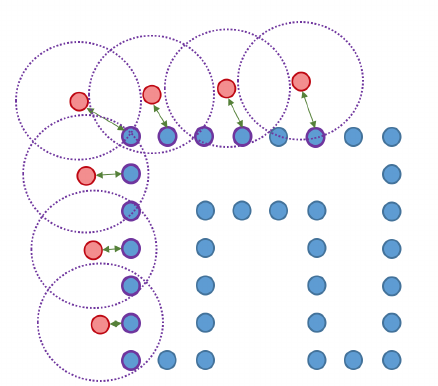
Figure 14. Toy example of the proposed shape accuracy and shape completeness measures. Assume that the estimated (red) and ground truth (blue) points are realigned, the point-to-point distances are given by—for each point in the possibly lower-dimensional estimated point cloud—finding the distance to the nearest neighbour in the ground truth point cloud. Completeness is estimated by marking observed points in the ground truth point cloud as observed if they are within a certain radius of an estimated point (illustrated in